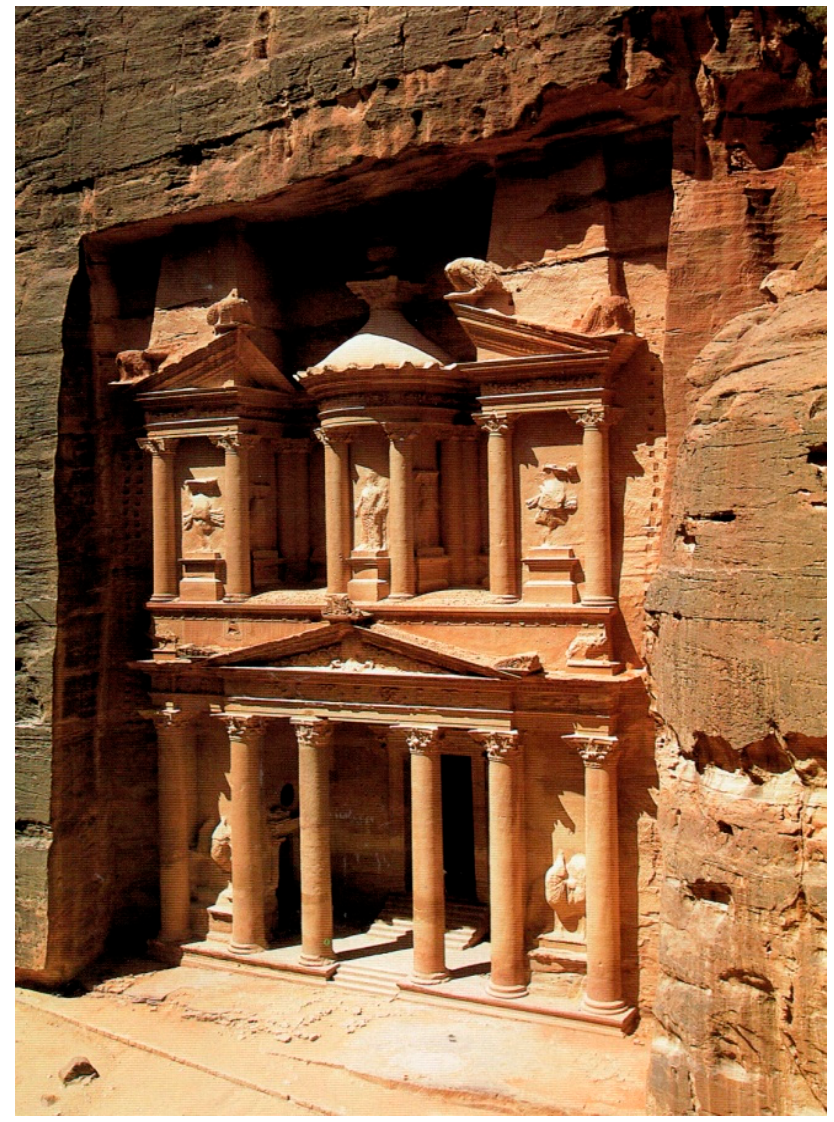
Figure 7. The Treasury, located at the Siq exit.